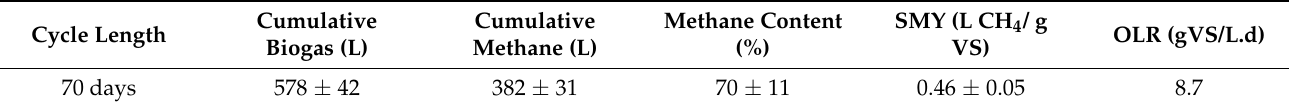
Table 2. Average values of a two-stage